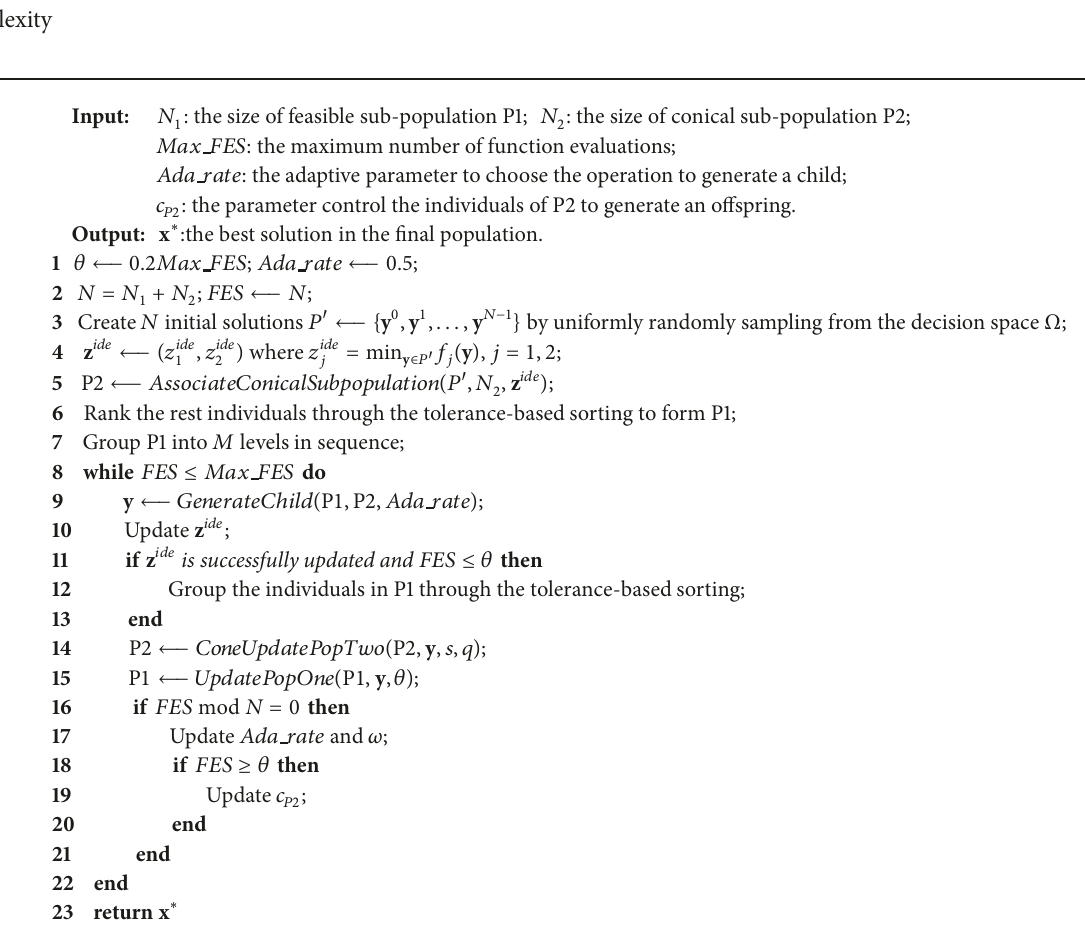
Algorithm 1: The framework of